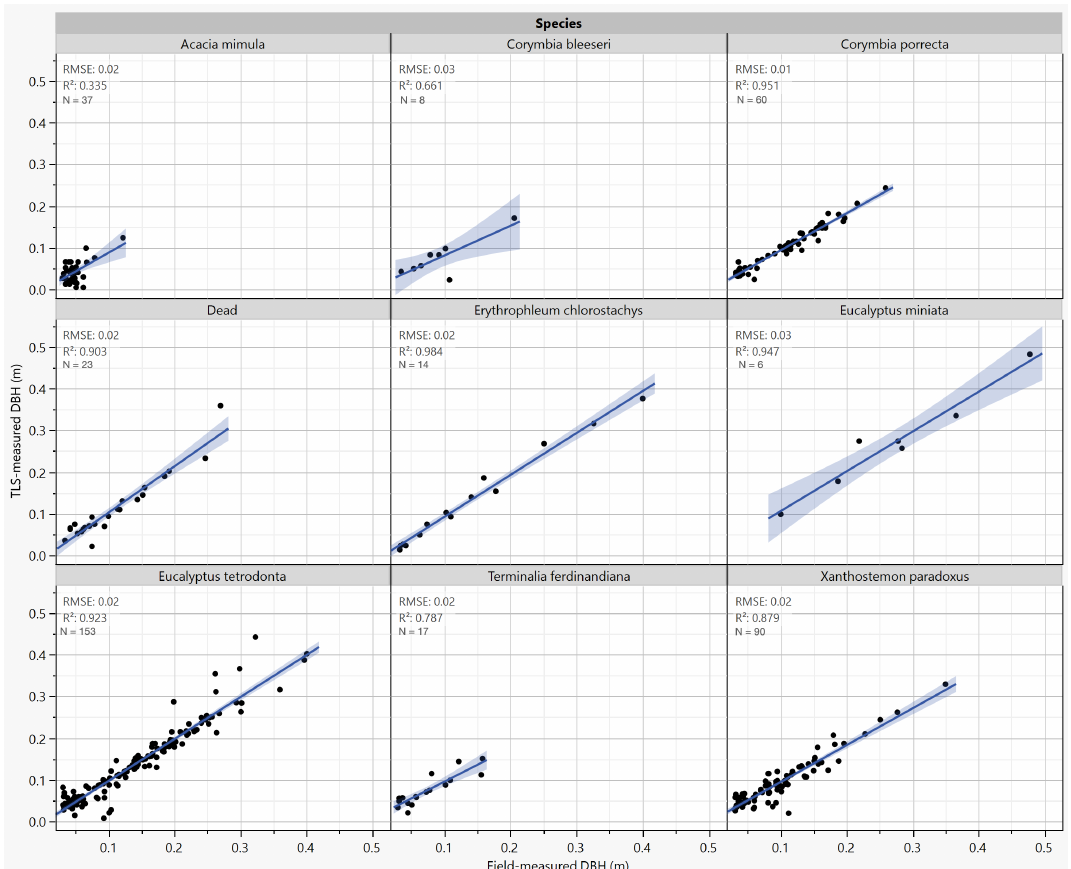
Figure 10. Comparison of TLS-derived DBH with field-measured values for the dominant woody species.